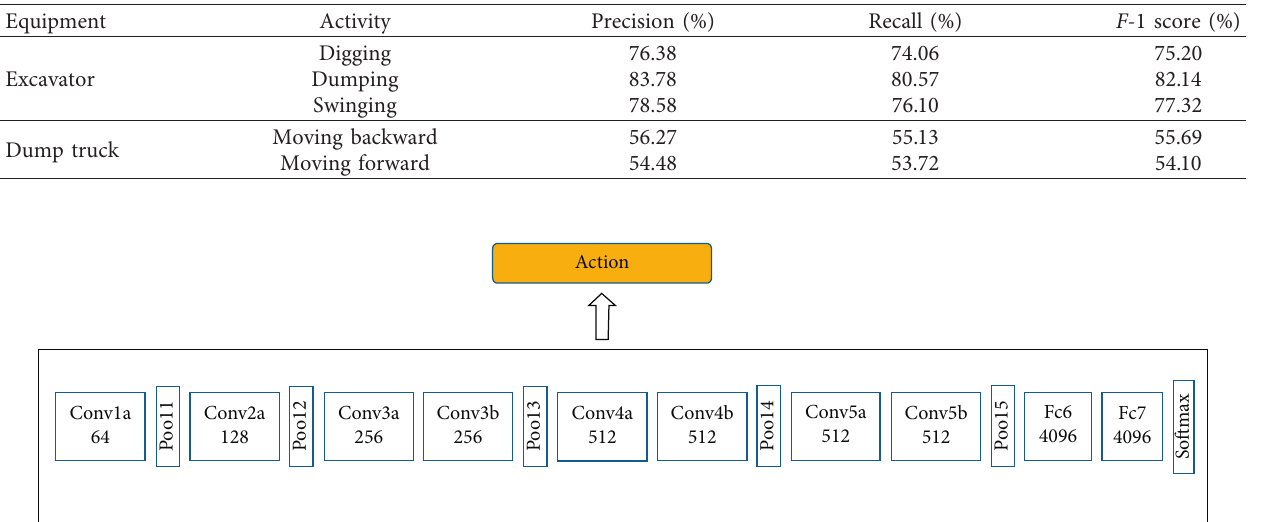
Table 6: Construction equipment action recognition results per activity.